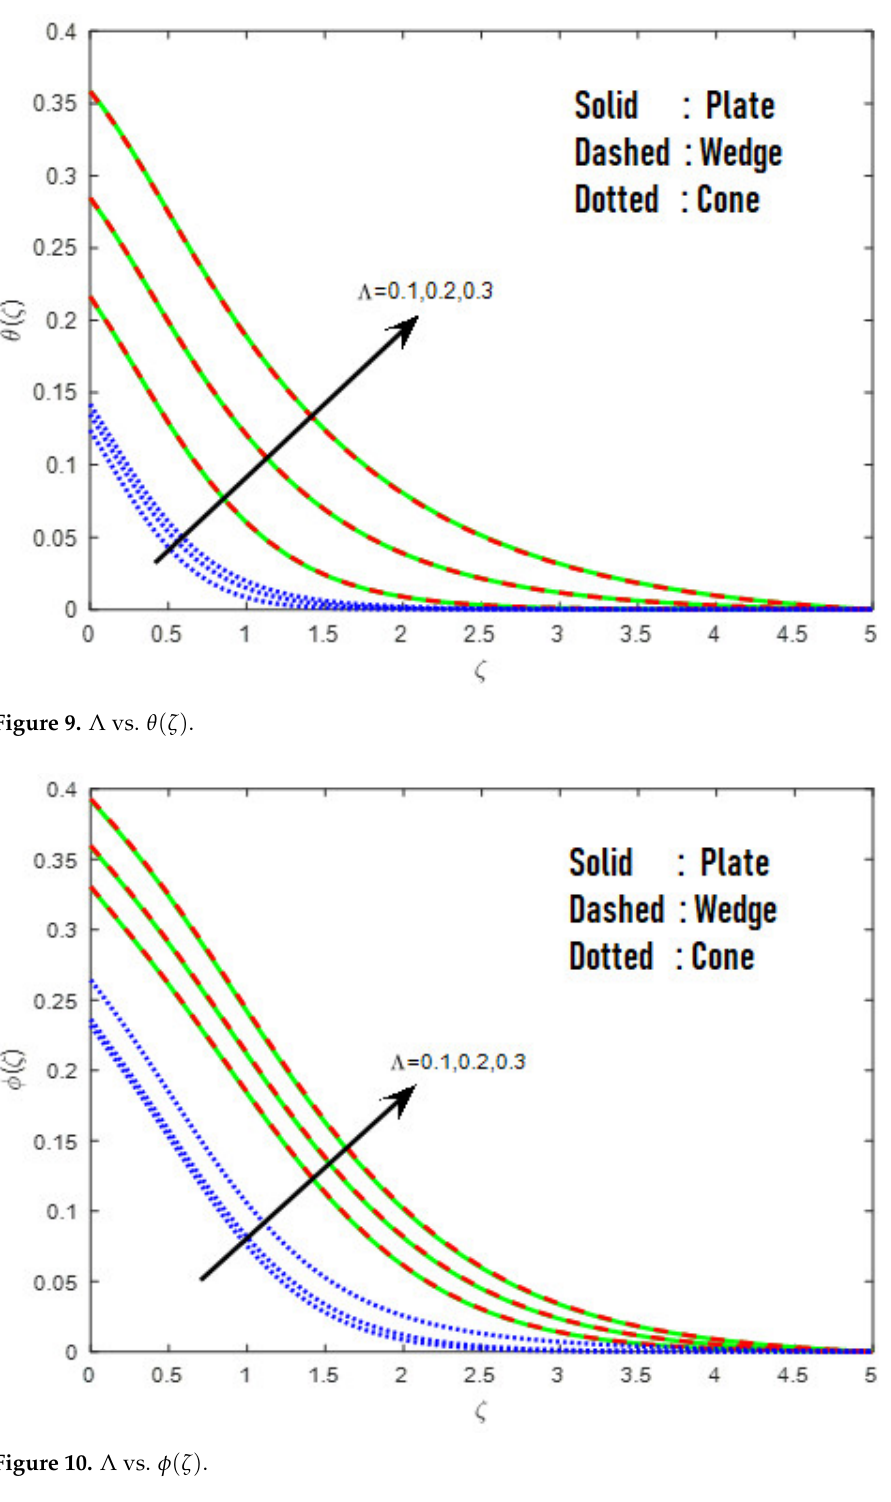
Figure 10. Λ vs. φ ( ζ ) Figure 10.  vs.     . Figure 10.  vs.     .